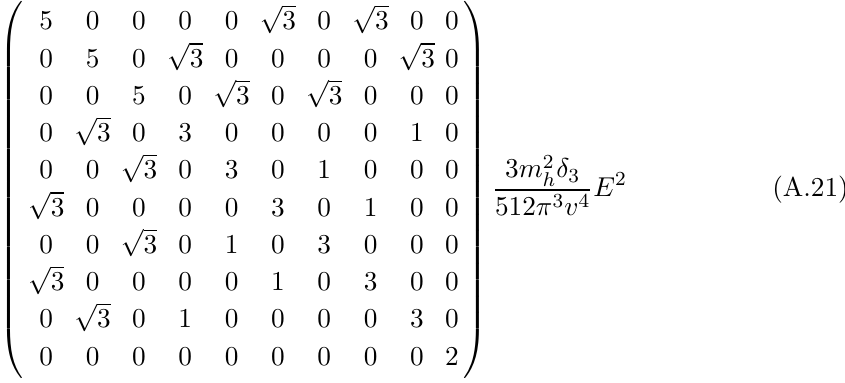
; G ; G g in the state. 1 2 3